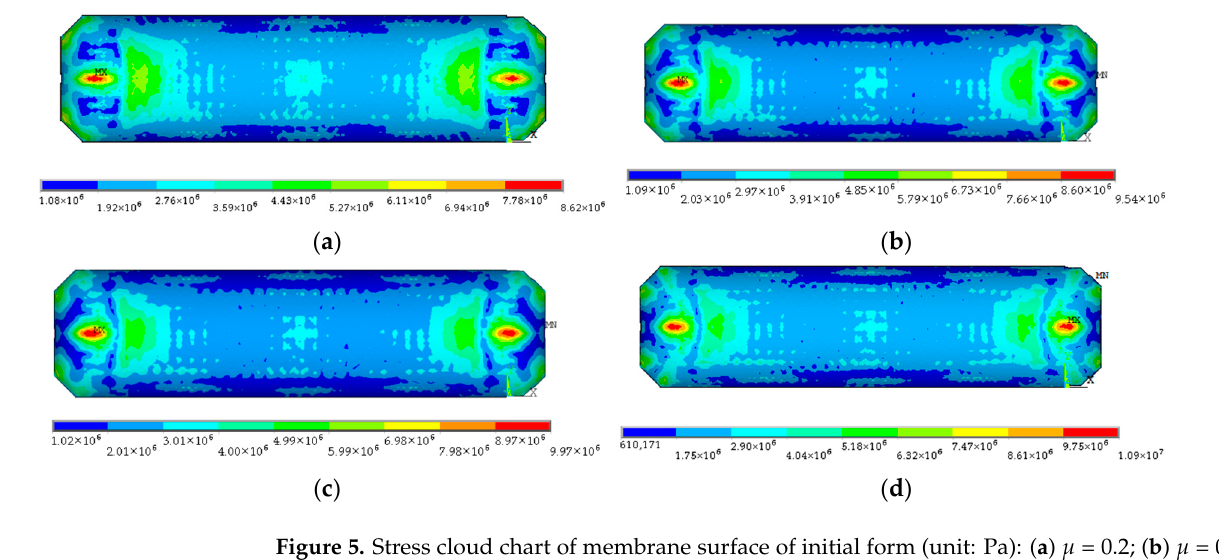
Figure 5. Stress cloud chart of membrane surface of initial form (unit: Pa): ( a ) μ = 0.2; ( b ) μ = 0.44; ( c ) μ = 0.68; and ( d ) μ = ∞ *.